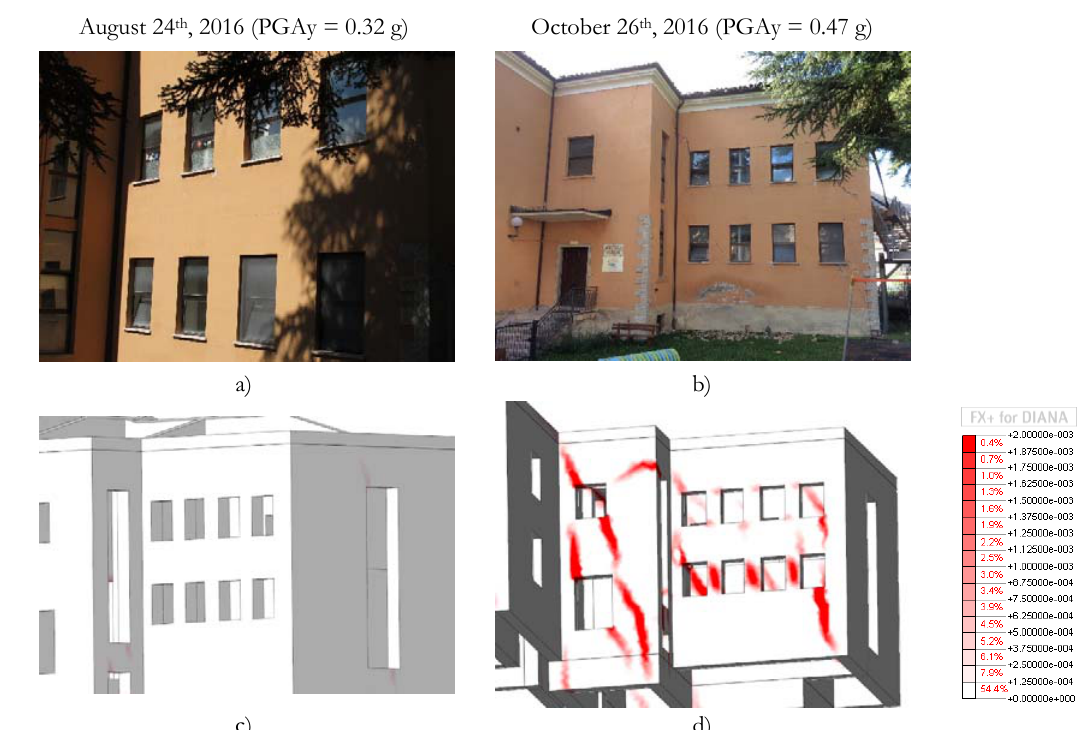
Figure 21: Correlation between the real and numerical damage occurred in the east external wall of body B due to the August 24 th (left) and October 26 th (right) earthquakes: a-b) cracks observed in-situ [11, 12], c) crack pattern in terms of principal crack width for a horizontal load of 0.32 g in the +Y direction, d) crack pattern in terms of principal crack width for a load of 0.42 g in the +Y direction.